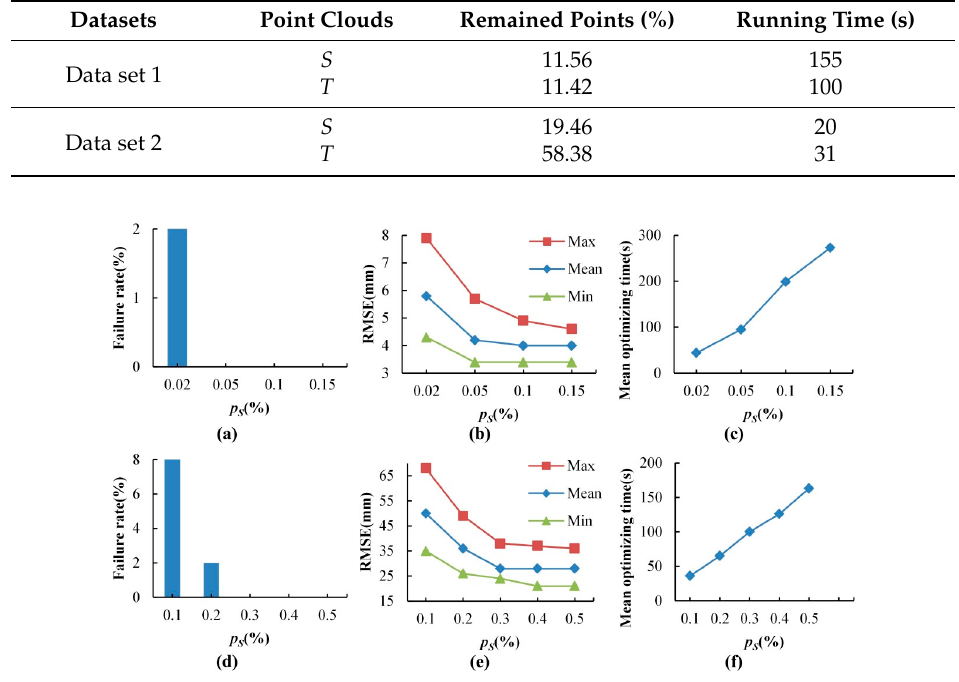
Figure 8. The failure rates, RMSEs and mean optimizing time of different sampling ratios. ( a – c ) are the results of data set 1. ( d – f ) are the results of data set 2. Sensors 2017 , 17 , 1979